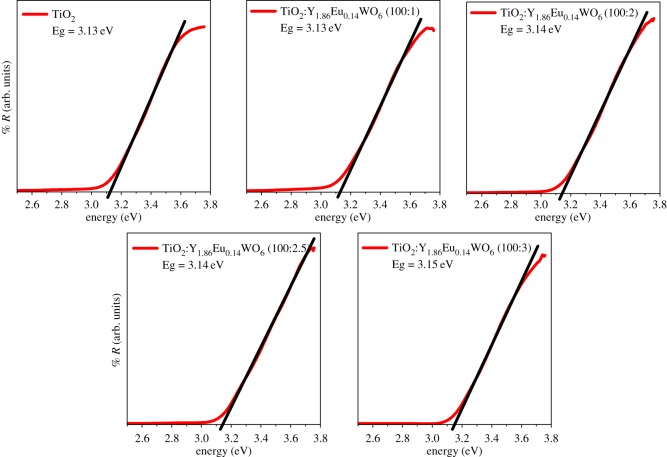
UV-visible diffuse reflectance curves of TiO2 mixed with different content of Y1.86Eu0.14WO6. The band gaps of pristine TiO2 and TiO2 with different contents of phosphors were calculated by the Tauc's plot method.